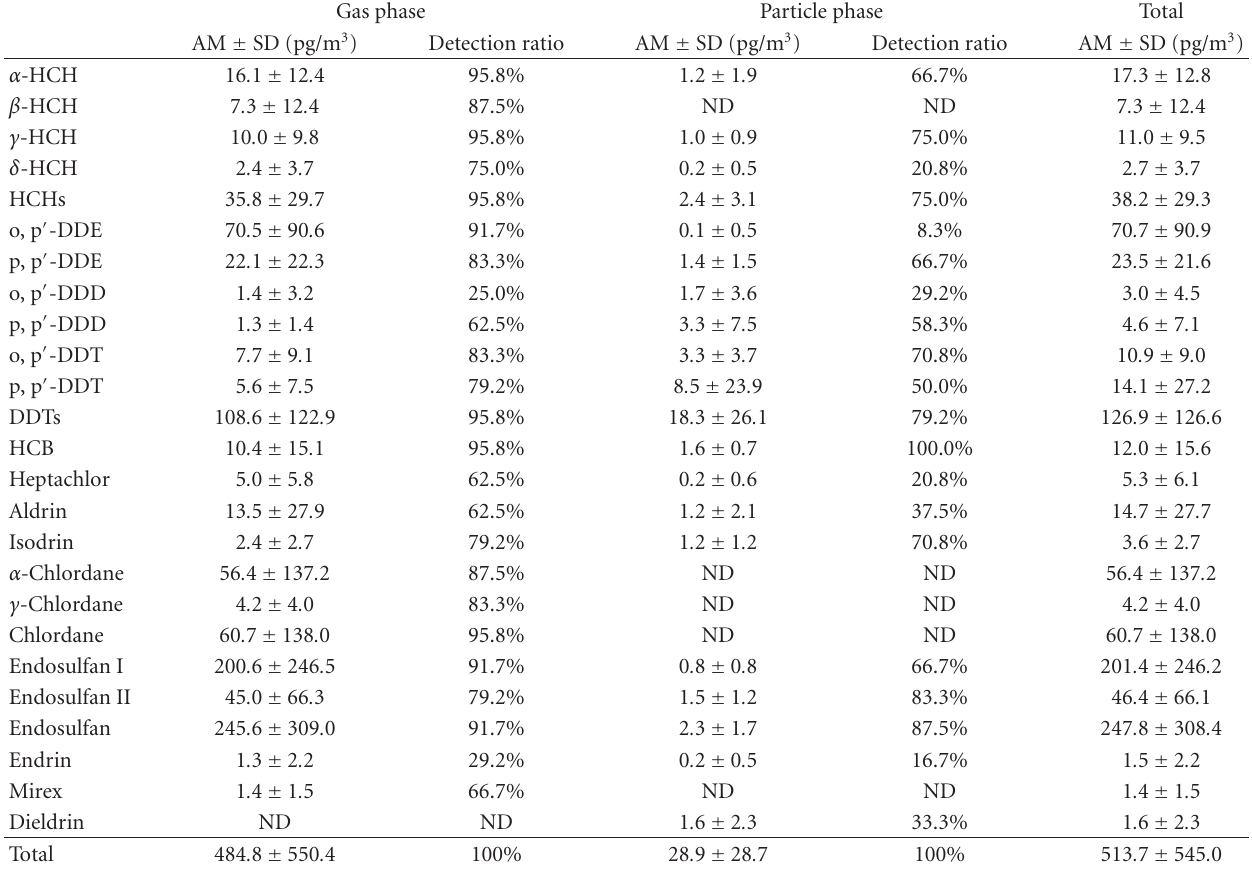
Table 2: Residual levels of OCPs in ambient air at Lake Chaohu from March 2010 to February